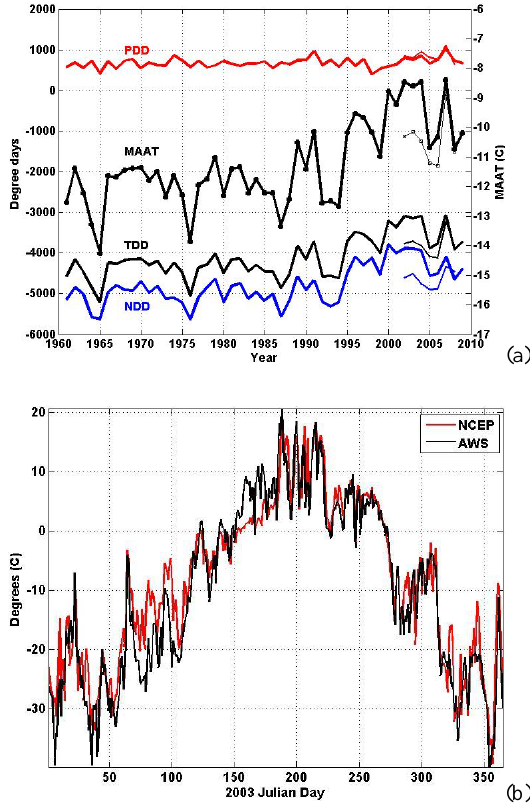
Fig. 3. Air temperature at Lake El’gygytgyn. In (a) , mean annual air temperature and degree days from NNR (thick lines) and AWS (thin lines), showing that NNR captures the AWS trends well and magnitude best in summer, which is most important to our study. Due to the pronounced warming trend starting in the late-1980s, we used the period 1961–1988 to define the modern era used in this study. In (b) , daily NNR is compared to local AWS showing that the trends and magnitude are captured well, though NNR fails to capture the coldest temperatures, causing about 1 ◦ C of misfit on